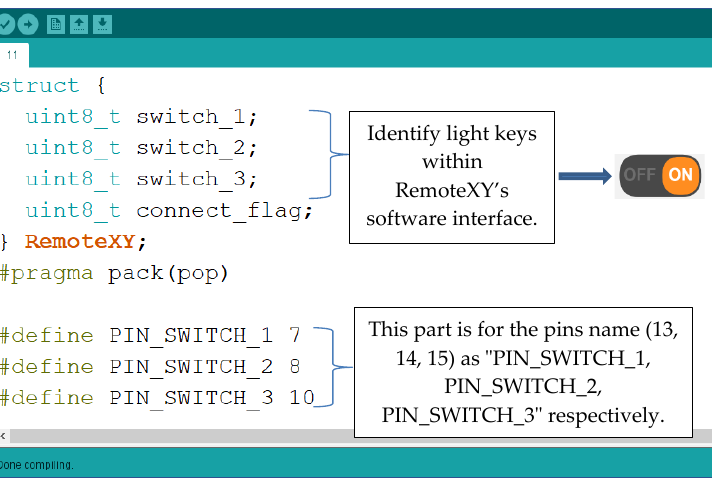
Figure A1. The first part of the executed code used to control lighting and sockets.